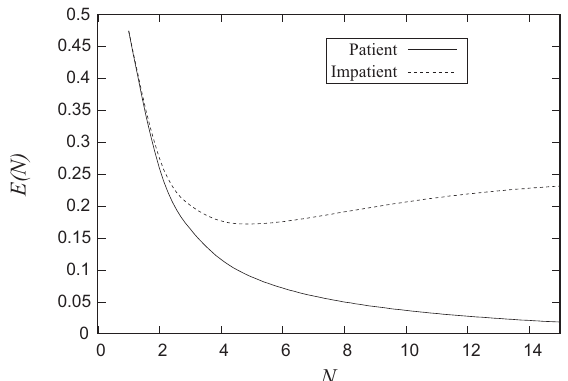
Figure 11. Dependence of the economical criterion E ( N ) on the number N